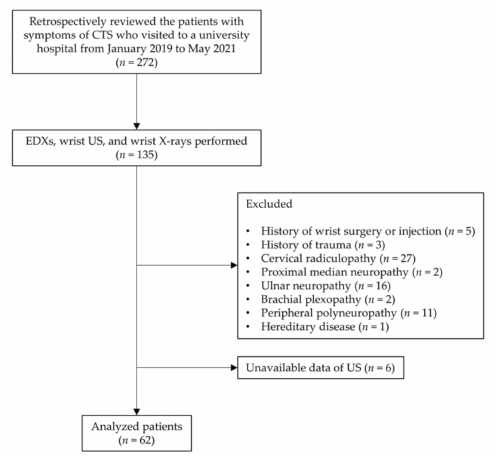
Figure 1. Study flow chart. Abbreviations: CTS, carpal tunnel syndrome; EDXs, electrodiagnostic studies; US,